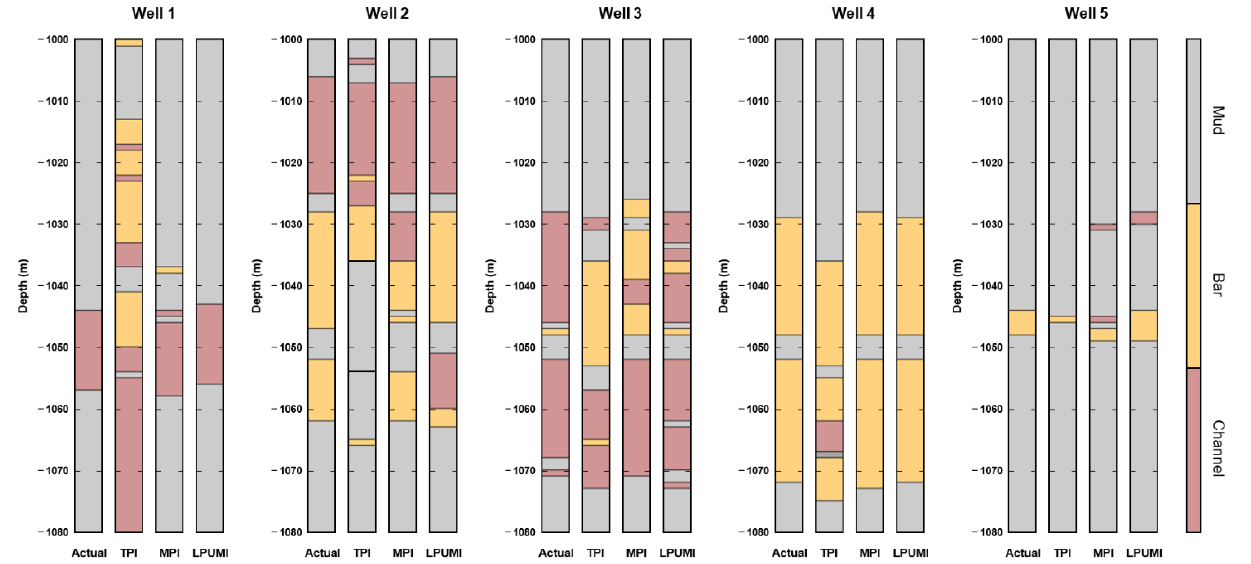
Figure 6. Seismic records obtained through well inversion (from top to bottom , real reservoir, TPI, MPI, and LPUMI).